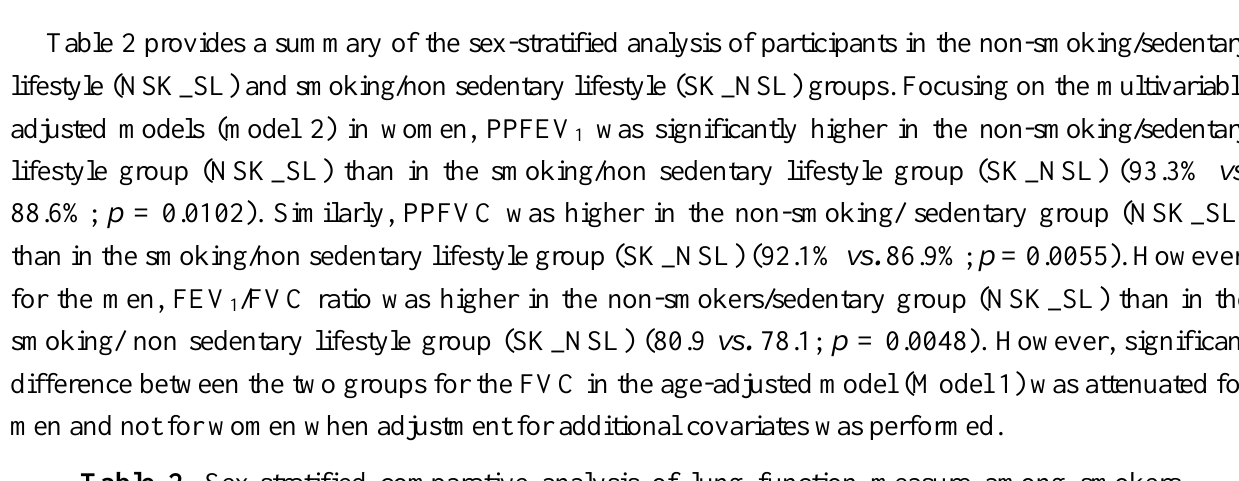
Table 2. Sex-stratified comparative analysis of lung function measure among smokers without sedentary lifestyle vs. non-smokers with sedentary